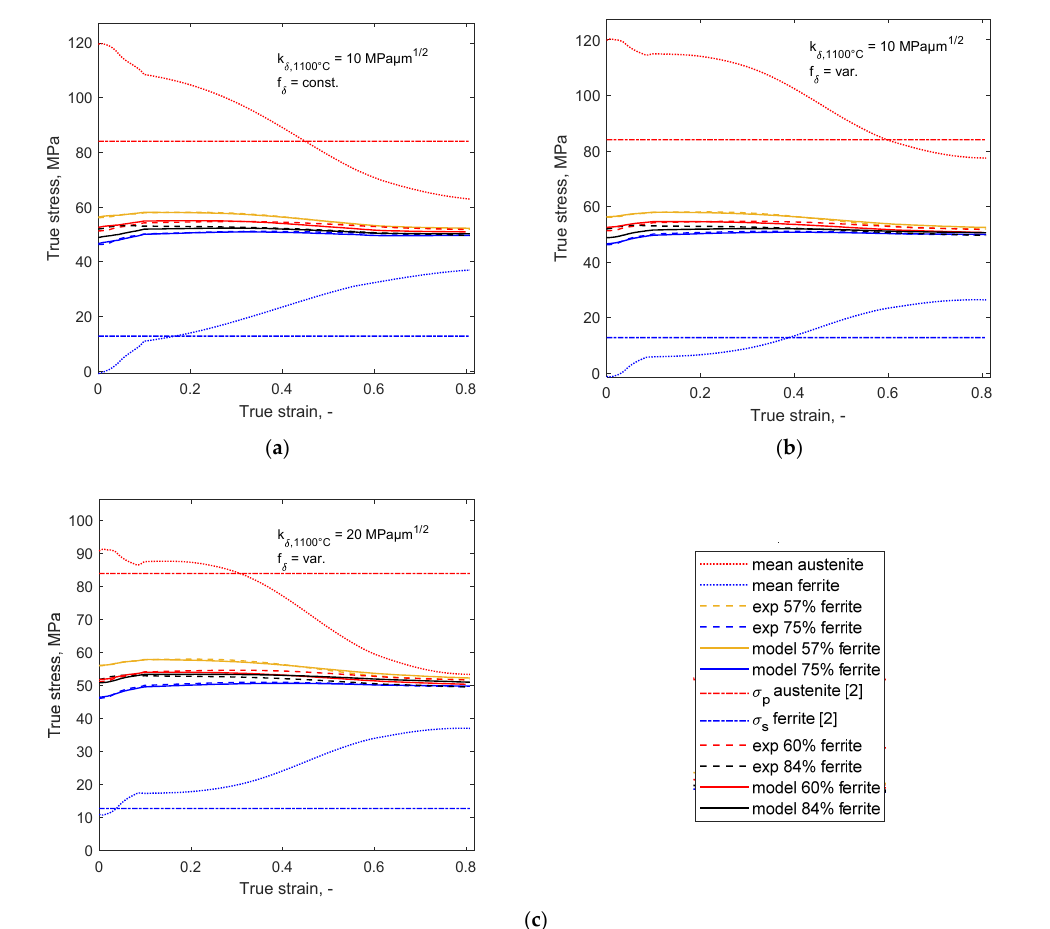
Figure 10. ( a ) Sensitivity study of fitting parameters for the duplex model for ( a ) constant initial ferrite fractions and Hall-Petch parameter of 10, ( b ) decreasing ferrite fractions during compression and Hall-Petch parameter of 10 MPaµm 1/2 and ( c ) decreasing ferrite fractions during compression and Hall-Petch parameter of 20 MPaµm 1/2 .